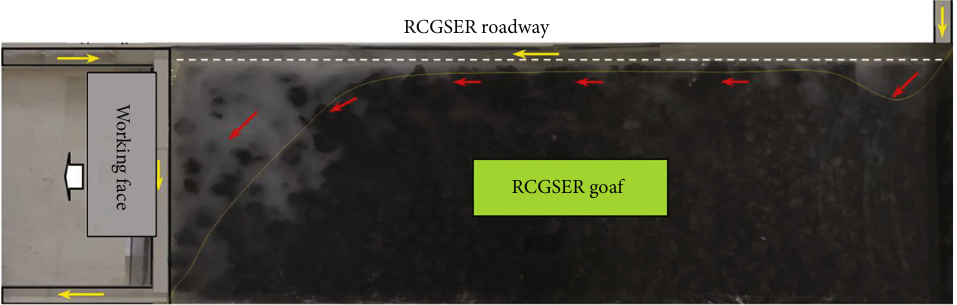
Figure 8: Experimental results of smoke fl ow in